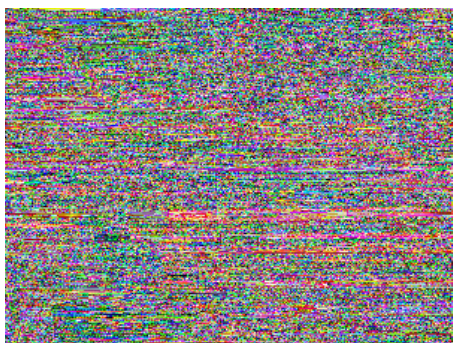
Figure 25. Decryption effect when the key entered is incorrect.